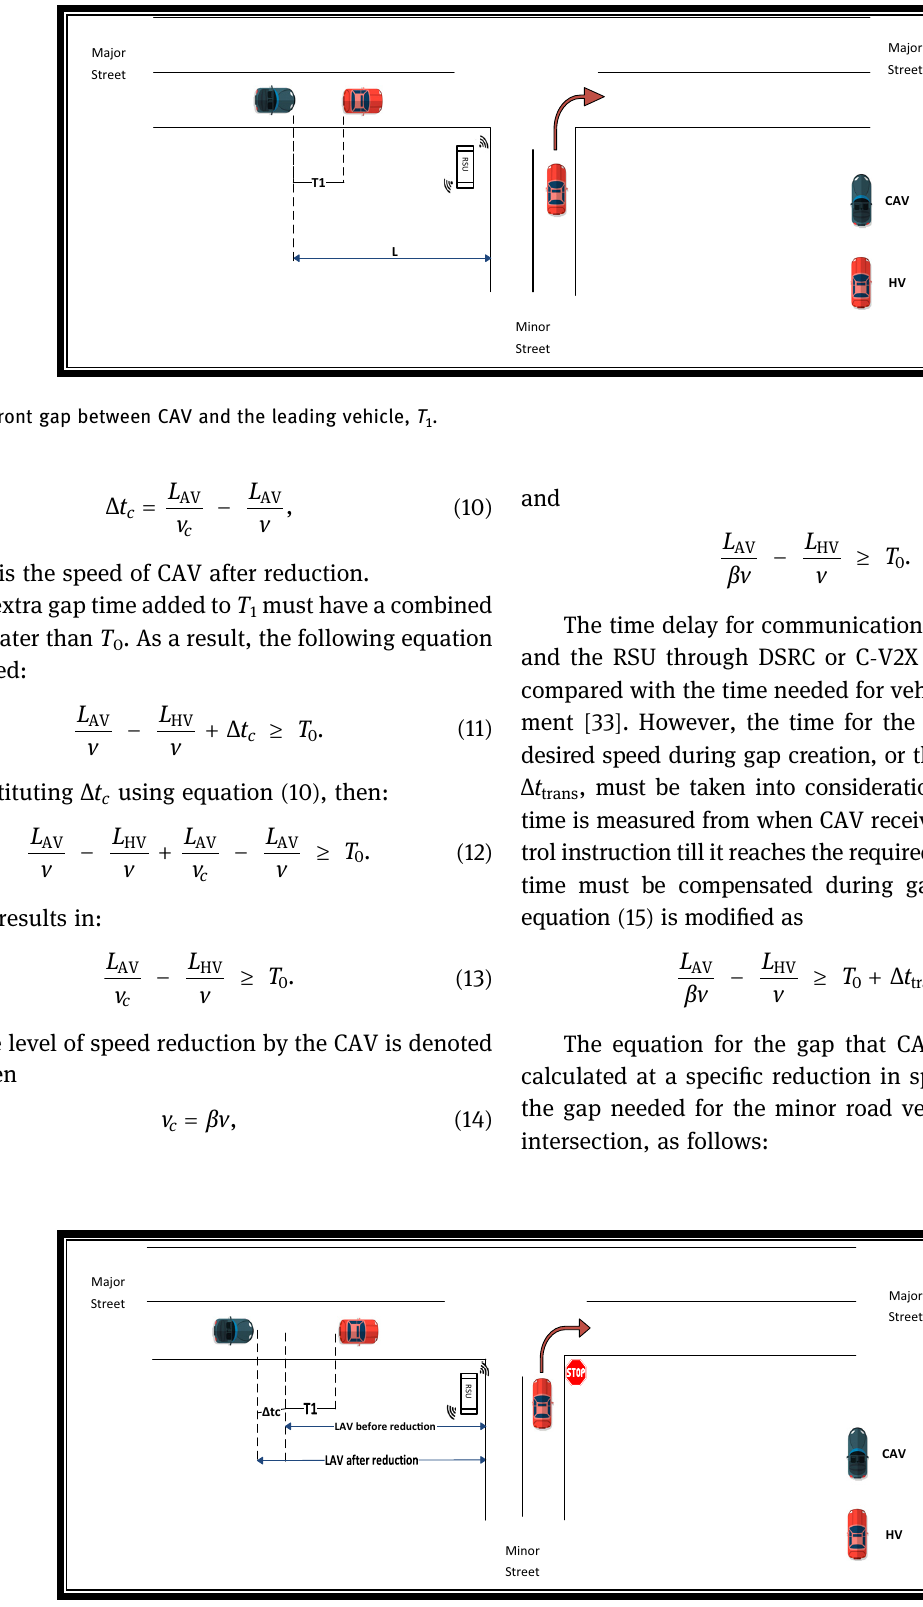
Figure 5: Extra time added to increase the gap time, t Δ c